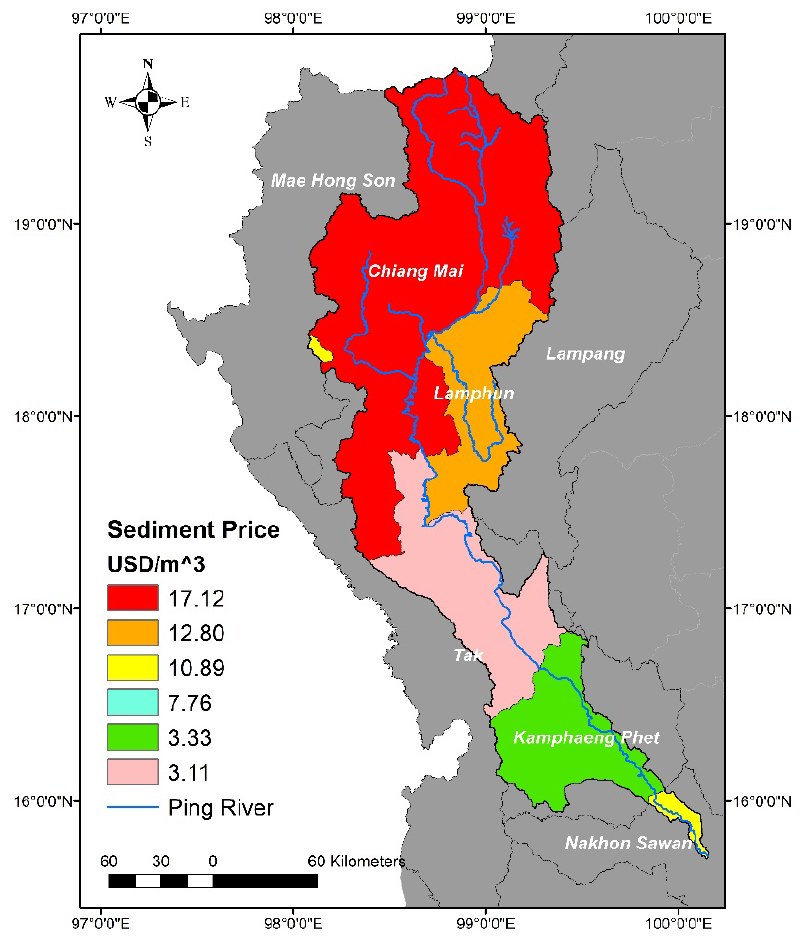
Figure 3. Sediment price map for the Ping River Basin.